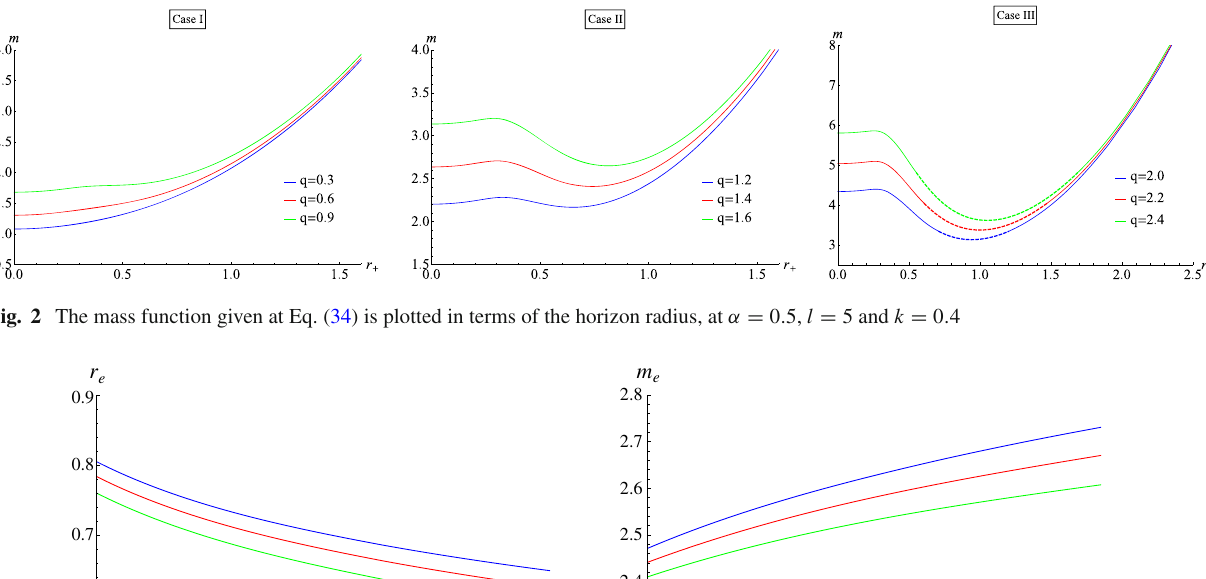
0.0 Fig. 3 The extremal radius and the extremal mass are plotted in terms of the inverse squared curvature radius 1 √ at α = 0 . 5 and q = 2. The blue, red, and green curves correspond to k = 0 . 3, 0.35, 0.4,